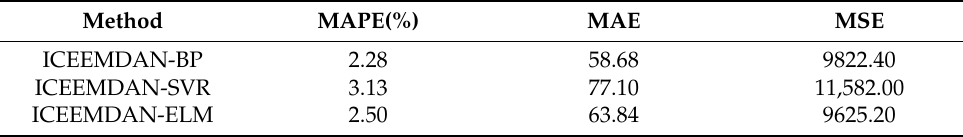
Table 4. Prediction results of different algorithms.